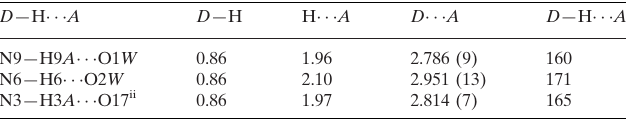
Hydrogen-bond geometry (A˚ , (cid:4)